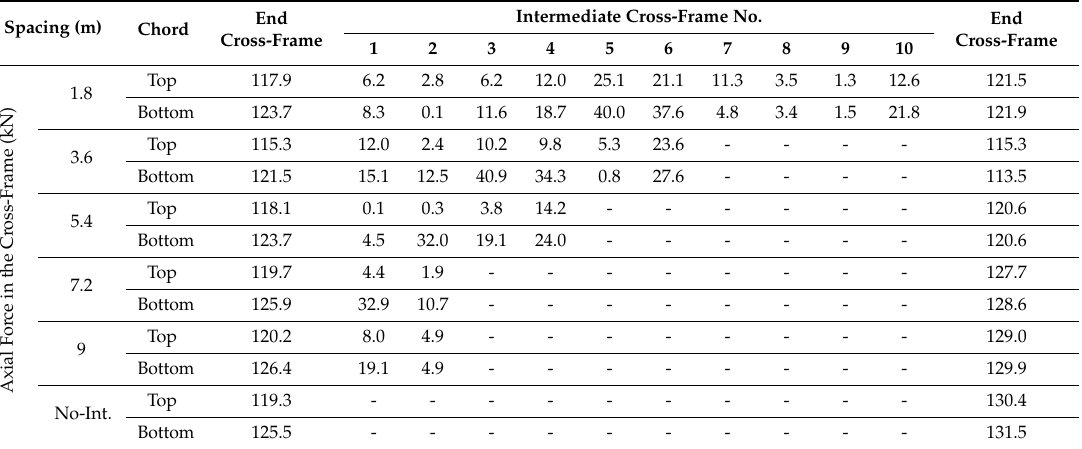
Table 6. Axial force in the cross-frames under dead load and one- time HL93 loading in the Twin I-girder